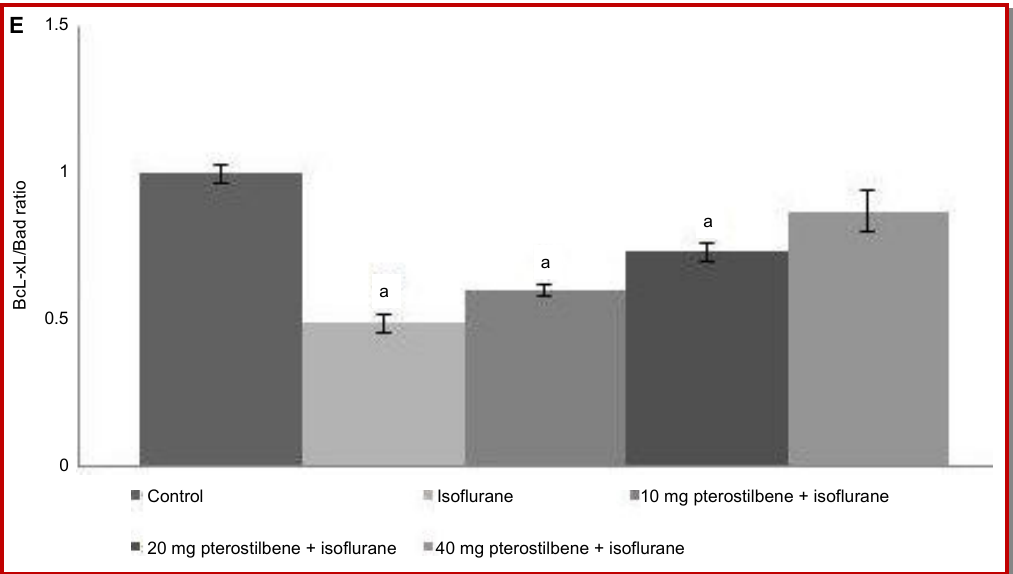
Figure 2E: Influence of pterostilbene on Bcl-xL/Bad ratio Values are represented as mean ± SD; n=6; a represents statistical significance at p<0.05 compared against control as determined by one -way ANOVA